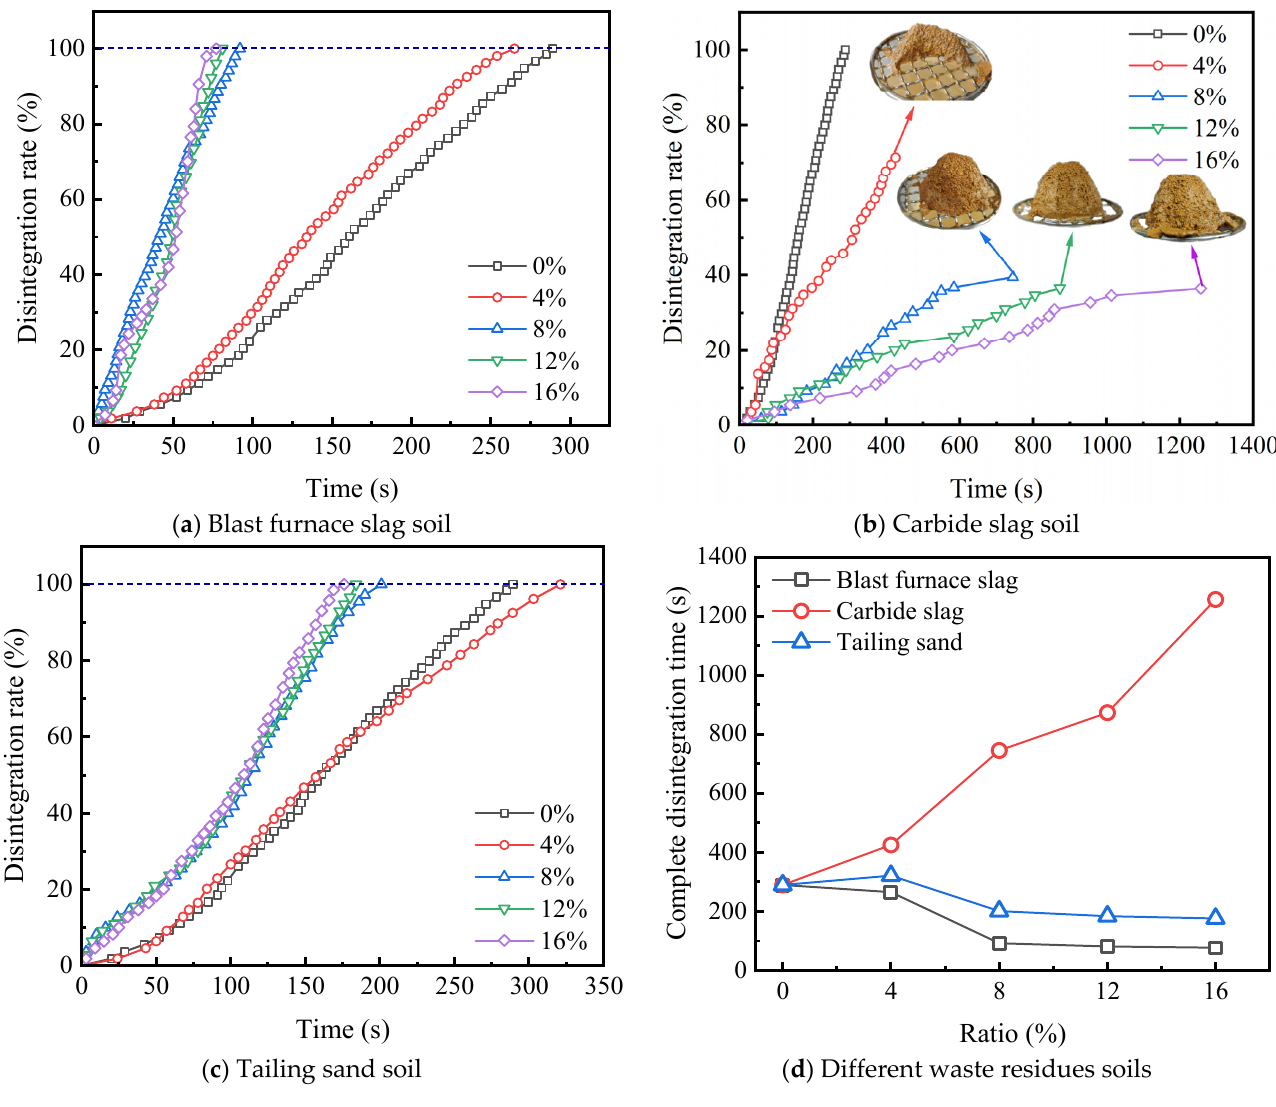
Figure 8. Disintegration curves of different waste residues soils.